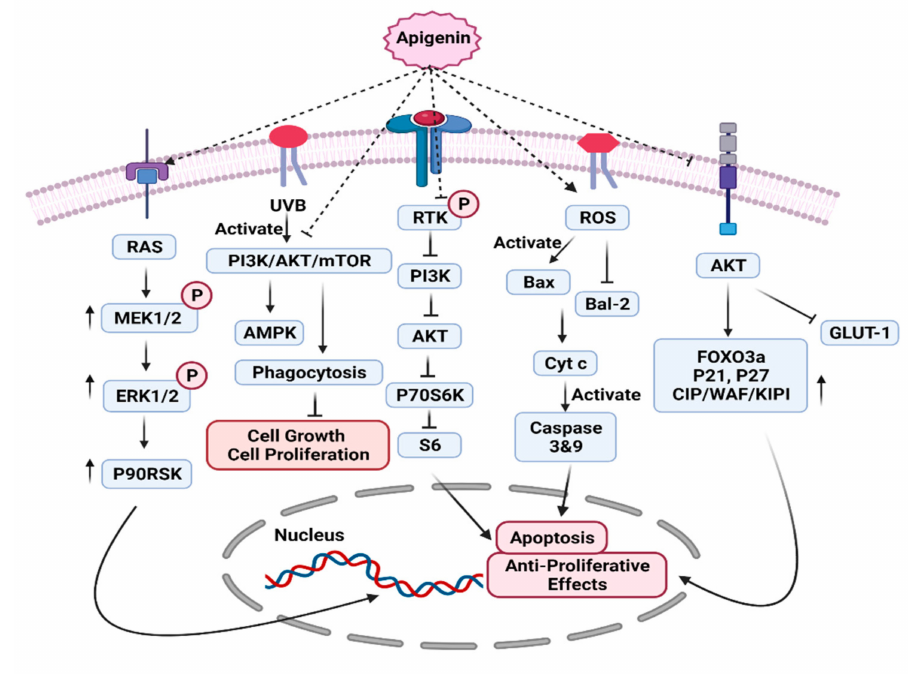
Figure 2. Modulation of PI3K/AKT/MTOR pathway by